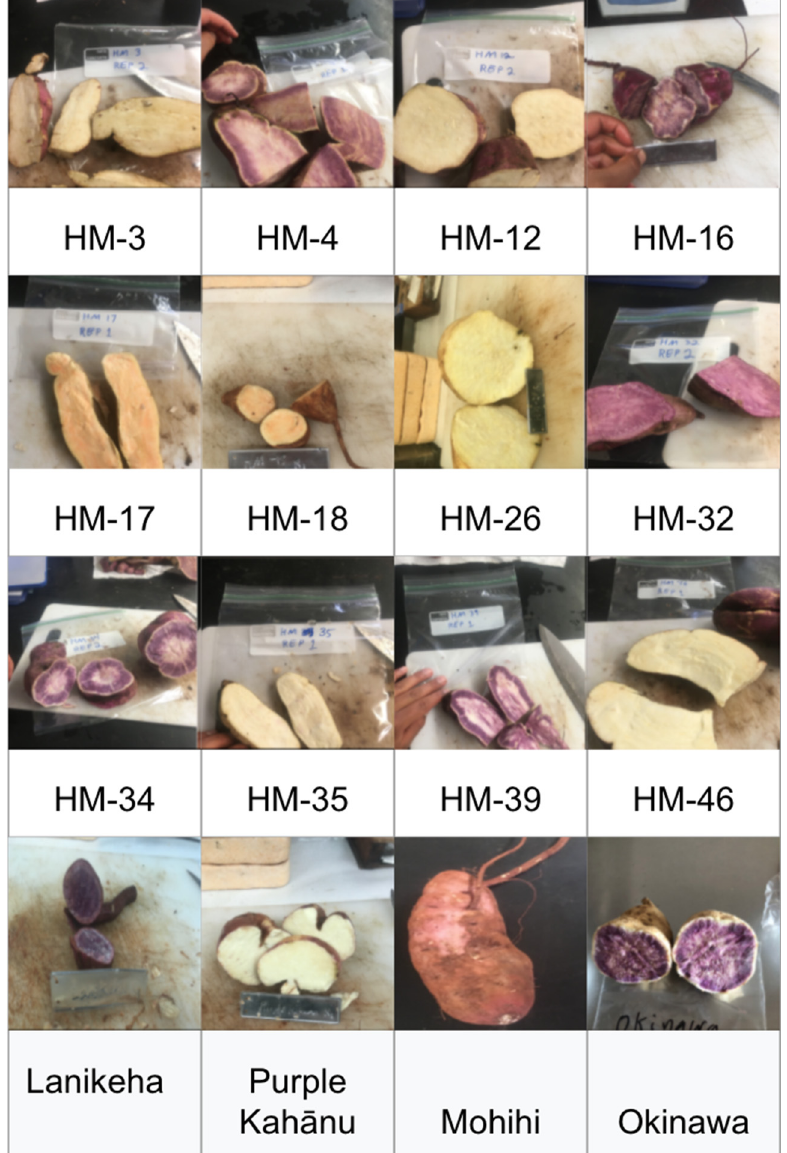
Figure 1. ‘Hawaiian Heritage’ breeding lines and check cultivars evaluated during this experiment. Okinawan is the commercial standard in Hawai’i, while Mohihi from Lyon arboretum is the maternal parent, Purple Kah ā nu and Lanikeha are traditional Hawaiian varieties.